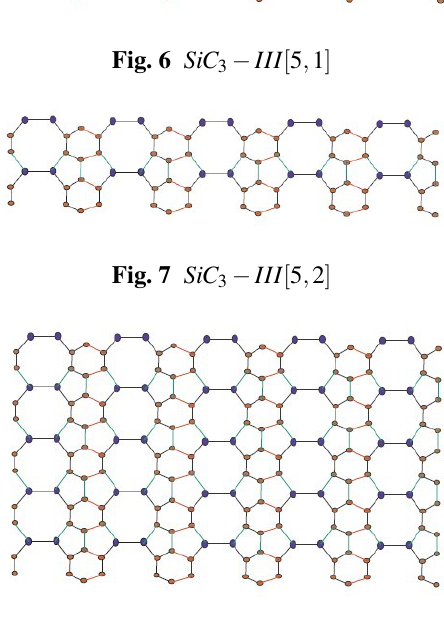
Fig. 6 SiC 3 − III [ 5 , 1 ]